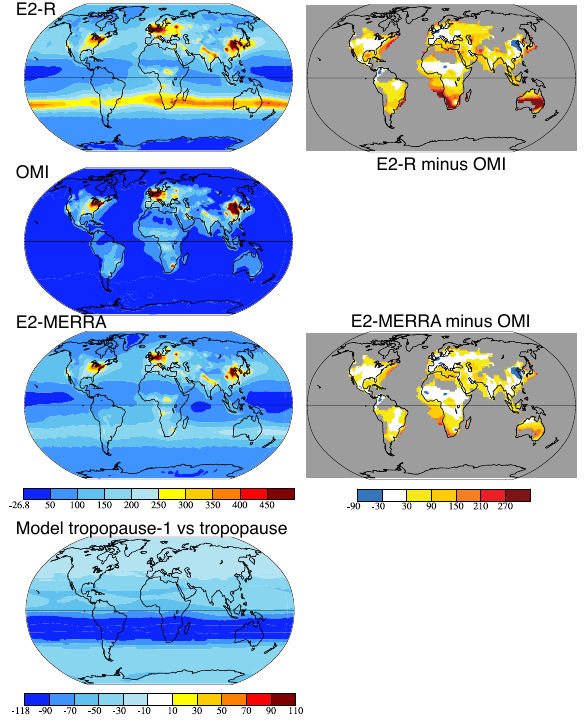
Fig. 8. Annual average 2005–2010 tropospheric NO 2 column (10 13 molecules cm − 2 ) at 13:30 local time in the E2-R run (top left), OMI observations (2nd row left), and the E2-MERRA run (3rd row left). Percentage differences between the models and OMI are shown in the right column for areas with at least 50 × 10 13 moleculescm − 2 . Also shown is the column difference in the E2-MERRA run when sampled using the model’s tropopause and one level below the tropopause (lower